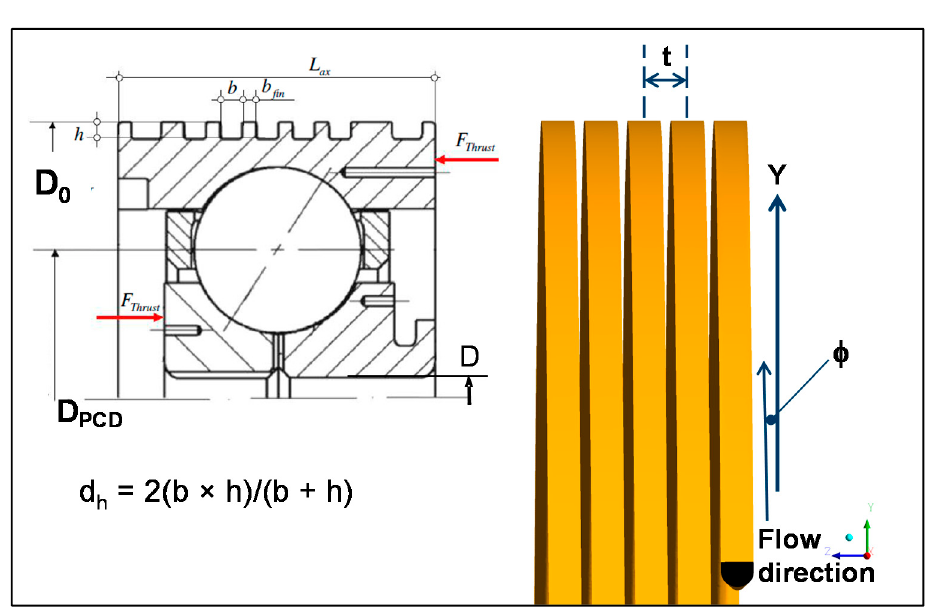
Figure 9. Bearing with D 0 and D PCD the outer and pitch circle diameters, the groove width b , the fin width b fin , the total axial length L ax , the pitch t of the groove and the pitch angle φ. The outer ring diameter (coil diameter) is given by D w = ( D 0 – h ) and represents the mean thread diameter. Due to the pitch angle φ the real coil diameter (diameter of the coil curvature D cor ) is not vertical, but oblique. According to [9], the corrected diameter can be calculated using the following relation,